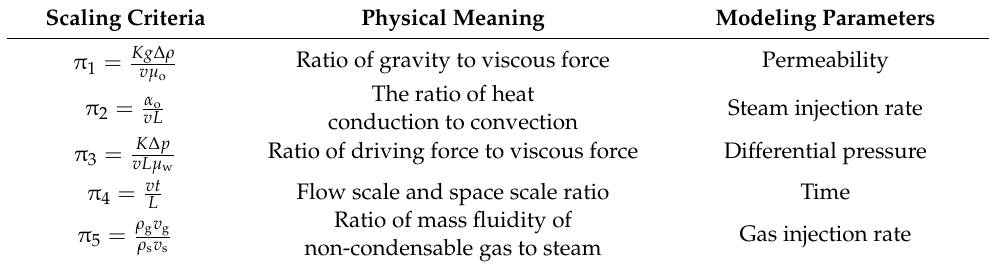
Table 1. Scaling